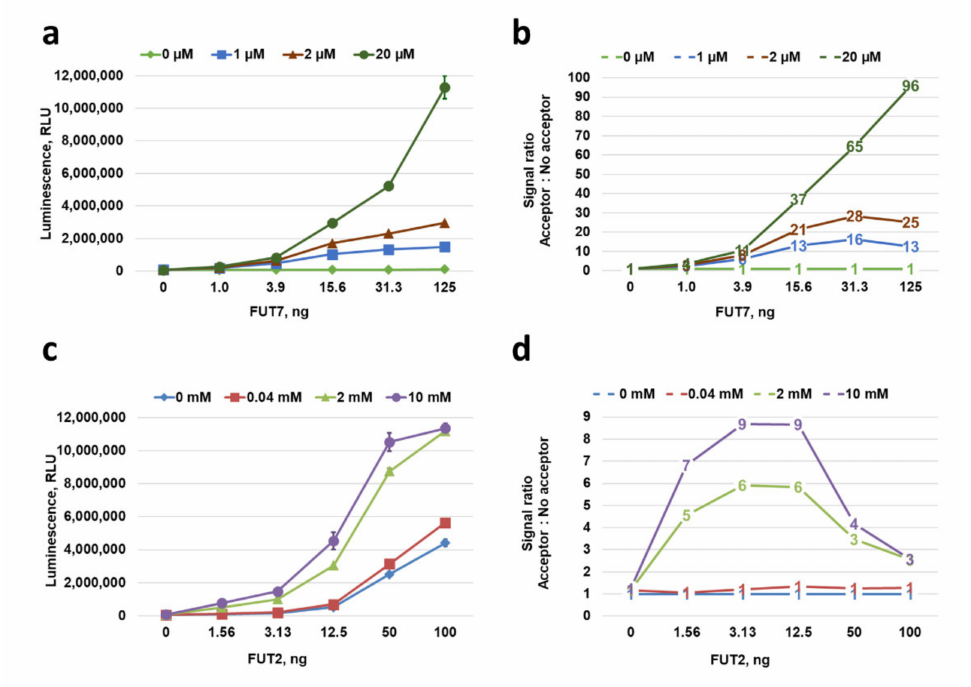
Figure 7. Detection of acceptor substrate-dependent and -independent GDP-Fucose hydrolysis of FUT7 and FUT2 enzymes. ( a , c ) Luminescence signal generated from GDP-Fucose hydrolysis by FUT7 and FUT2 enzyme titrations in the absence or presence of different concentrations of the acceptor substrate Fetuin or LacNAc, respectively. ( b , d ) Signal windows generated with each enzyme and acceptor substrate concentrations showing the absence (FUT7) or presence (FUT2) of intrinsic acceptor-independent GDP-sugar hydrolase